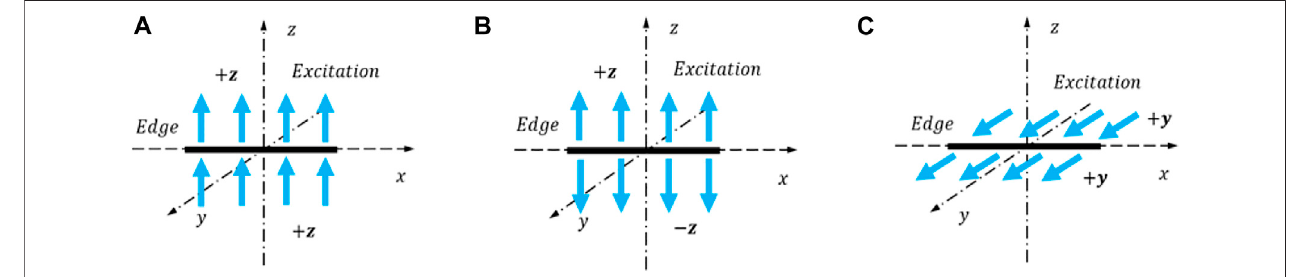
FIGURE 11 | Three types of excitation: (A) Antisymmetric excitation about the xy plane; (B) symmetric excitation; (C) antisymmetric excitation about the xz plane.